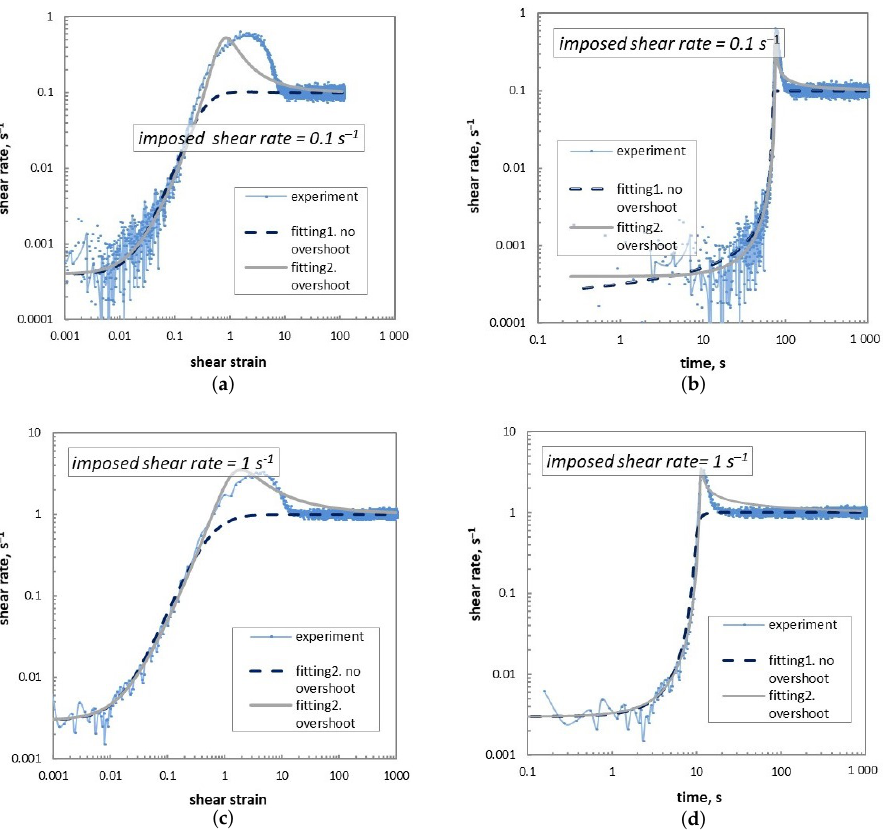
Figure 8. Fitting curves of shear rate history with and without overshoot in comparison with measured ones: ( a , b ) for ˙ γ = 0.1 s − 1 ; ( c , d ) for ˙ γ = 1 s − 1